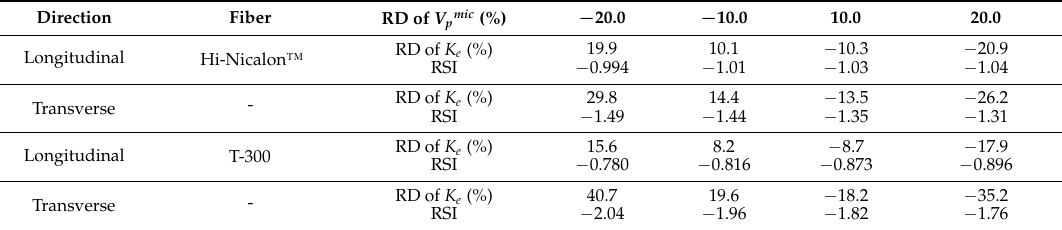
Table 8. Sensitivity analysis of porosity for 1D